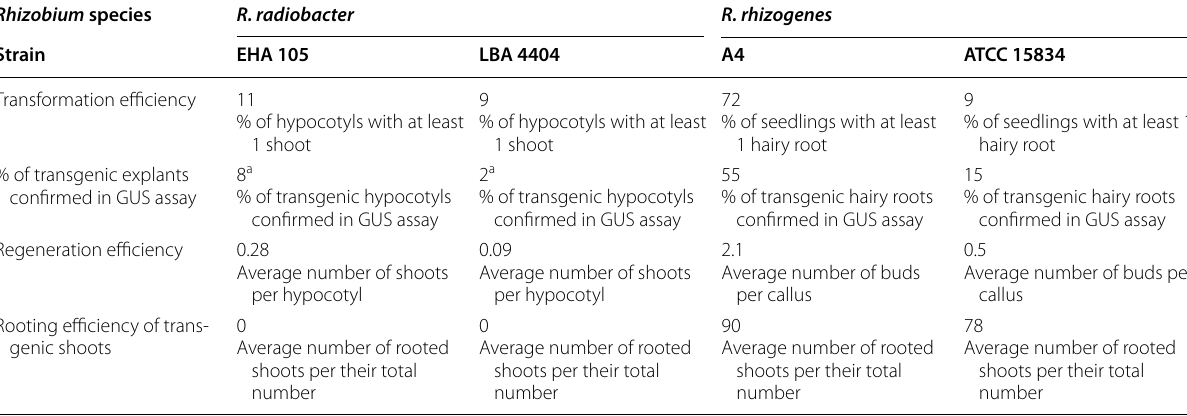
a Trace staining (spots) at the end of hypocotyls